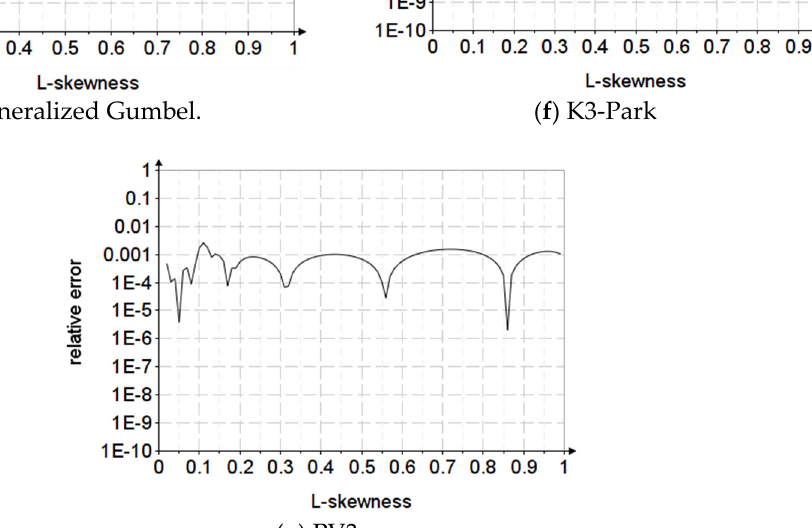
Figure 3. The variation of errors depending on τ 3